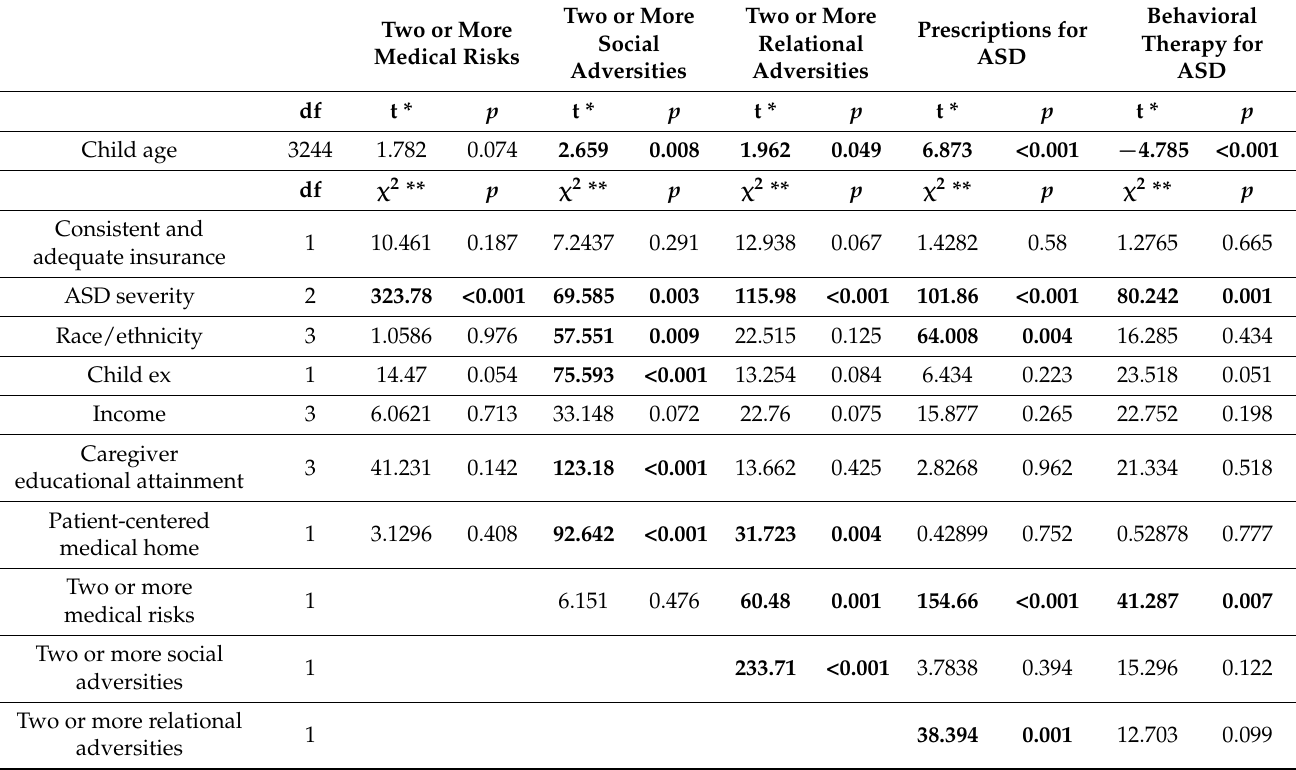
Table 2. Bivariate Associations Among Predisposing Characteristics, Enabling Factors, and Need Factors and ASD-Related Health Services